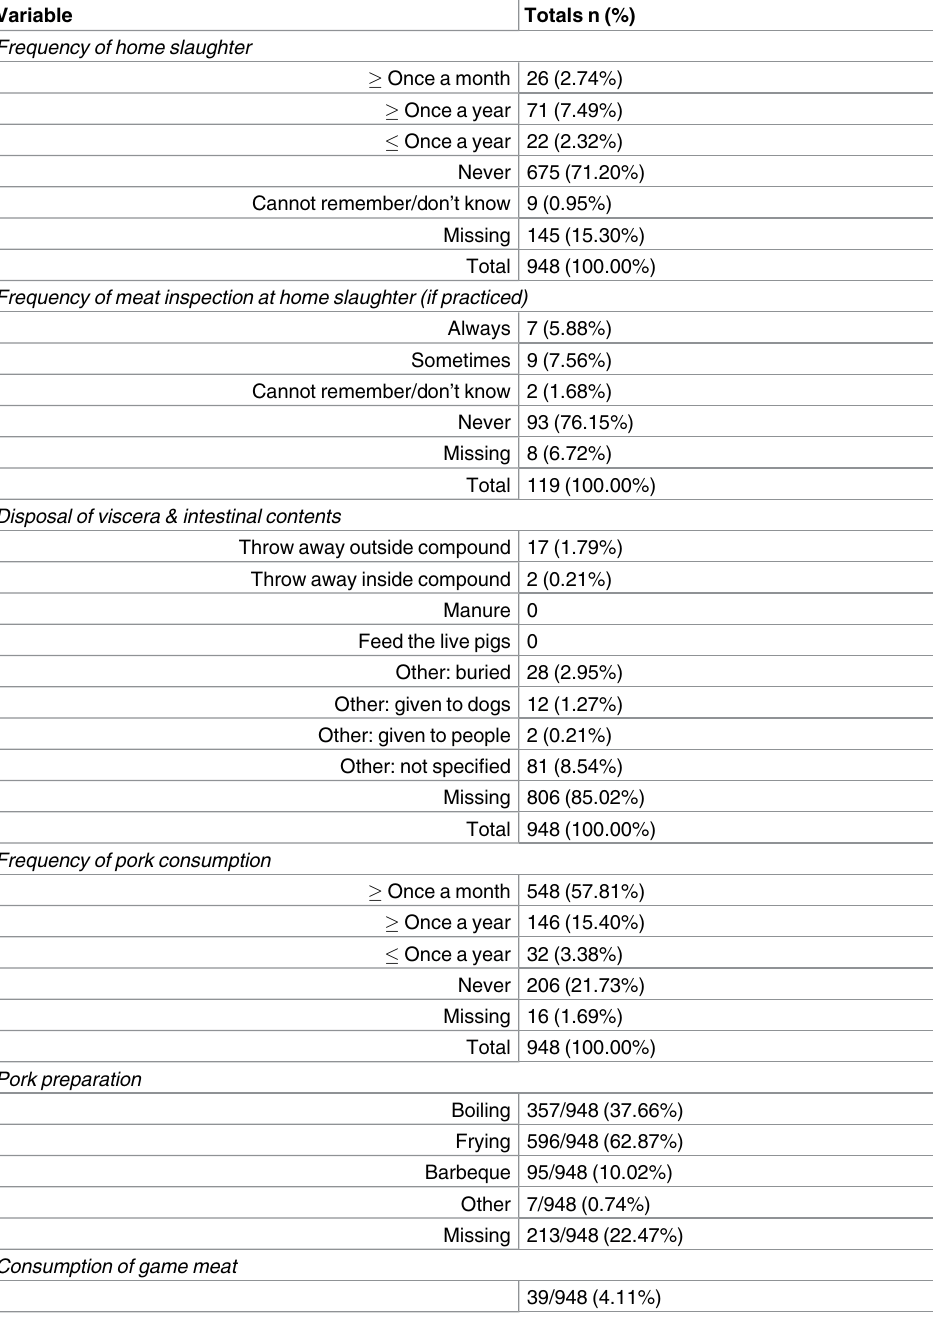
Table 3. Pig slaughter, processing and consumption practicesin Central and Eastern Uganda